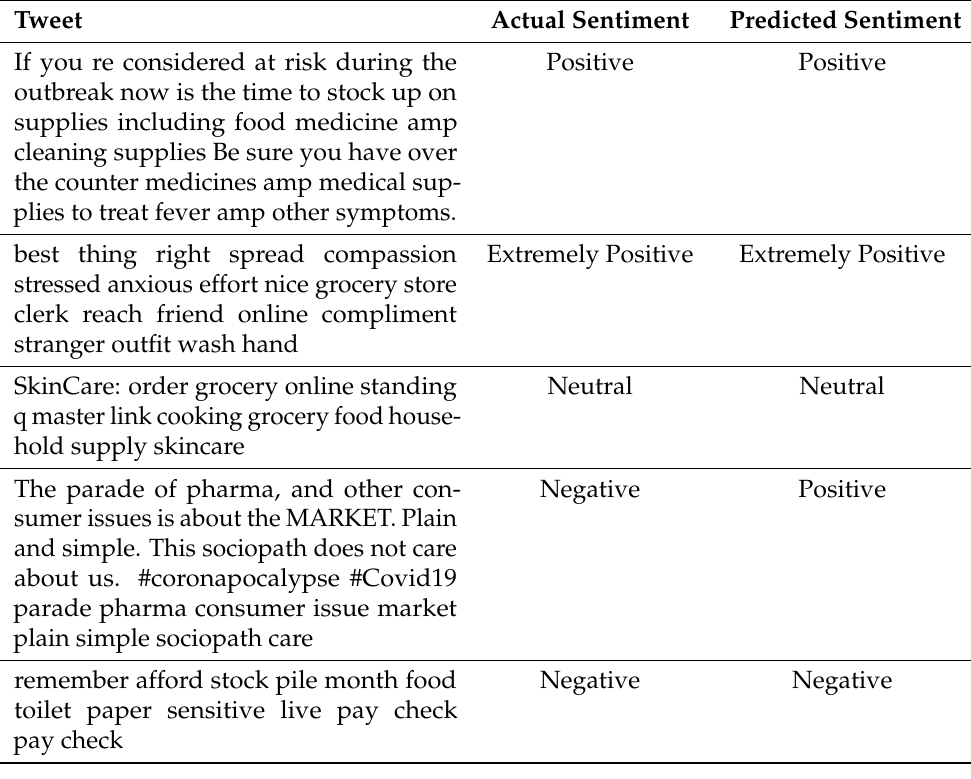
Table 7. Example tweets with actual and predicted sentiment